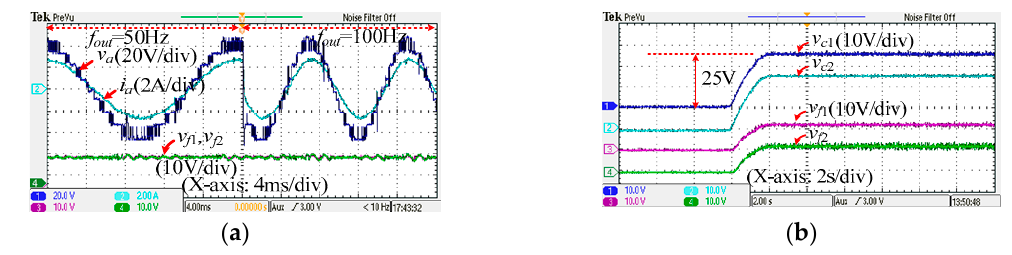
Figure 32. Transient-state experiment results of single-phase 9L HSM converter connected with linear RL -load. ( a ) Phase voltage v ao and load current i a , ( b ) dc-link capacitor voltages v c 1 , v c 2 and FC voltages v f 1 , v f 2